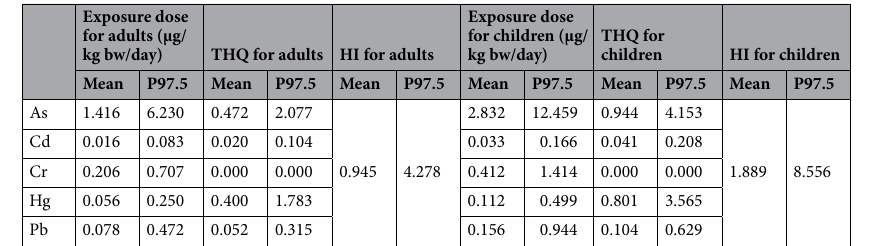
Exposure dose for adults (μg/ kg bw/day) THQ for adults HI for